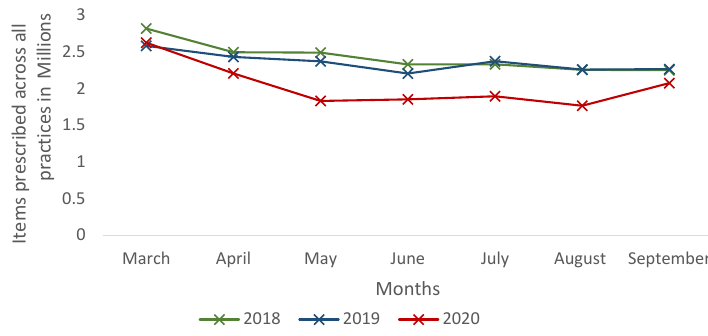
Figure 1. Number of first-line antibiotics prescribed in English primary care . Table 1. Number of first-line antibiotics prescribed in English primary care. Antibiotic